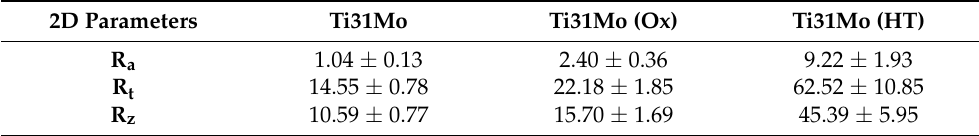
Table 3. Two-dimensional (R a , R t , R z ) parameters for the Ti31Mo alloy before modification, after NaOH 60 ◦ C/24 h, and hydrothermal treatment; parameters are taken from the surface area of 1.08 mm 2